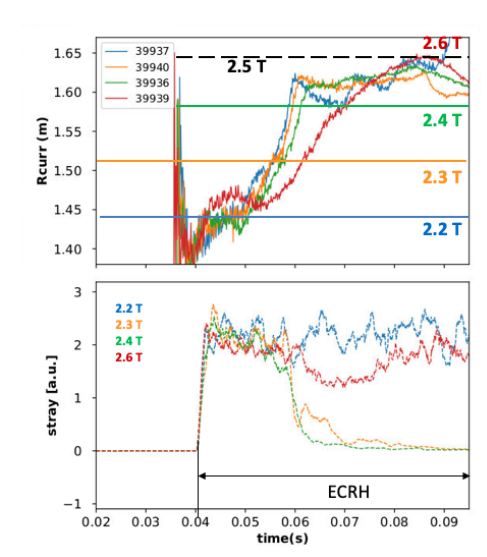
Figure 6. Top: Stray radiation increases with increasing Ne / D. Bottom: the derivative of the plasma current decreases (keeping the temperature low) and the burn-through of NeVii line starts with increasing delay. B tor : 2.4 T; P EC : 1.4 MW.